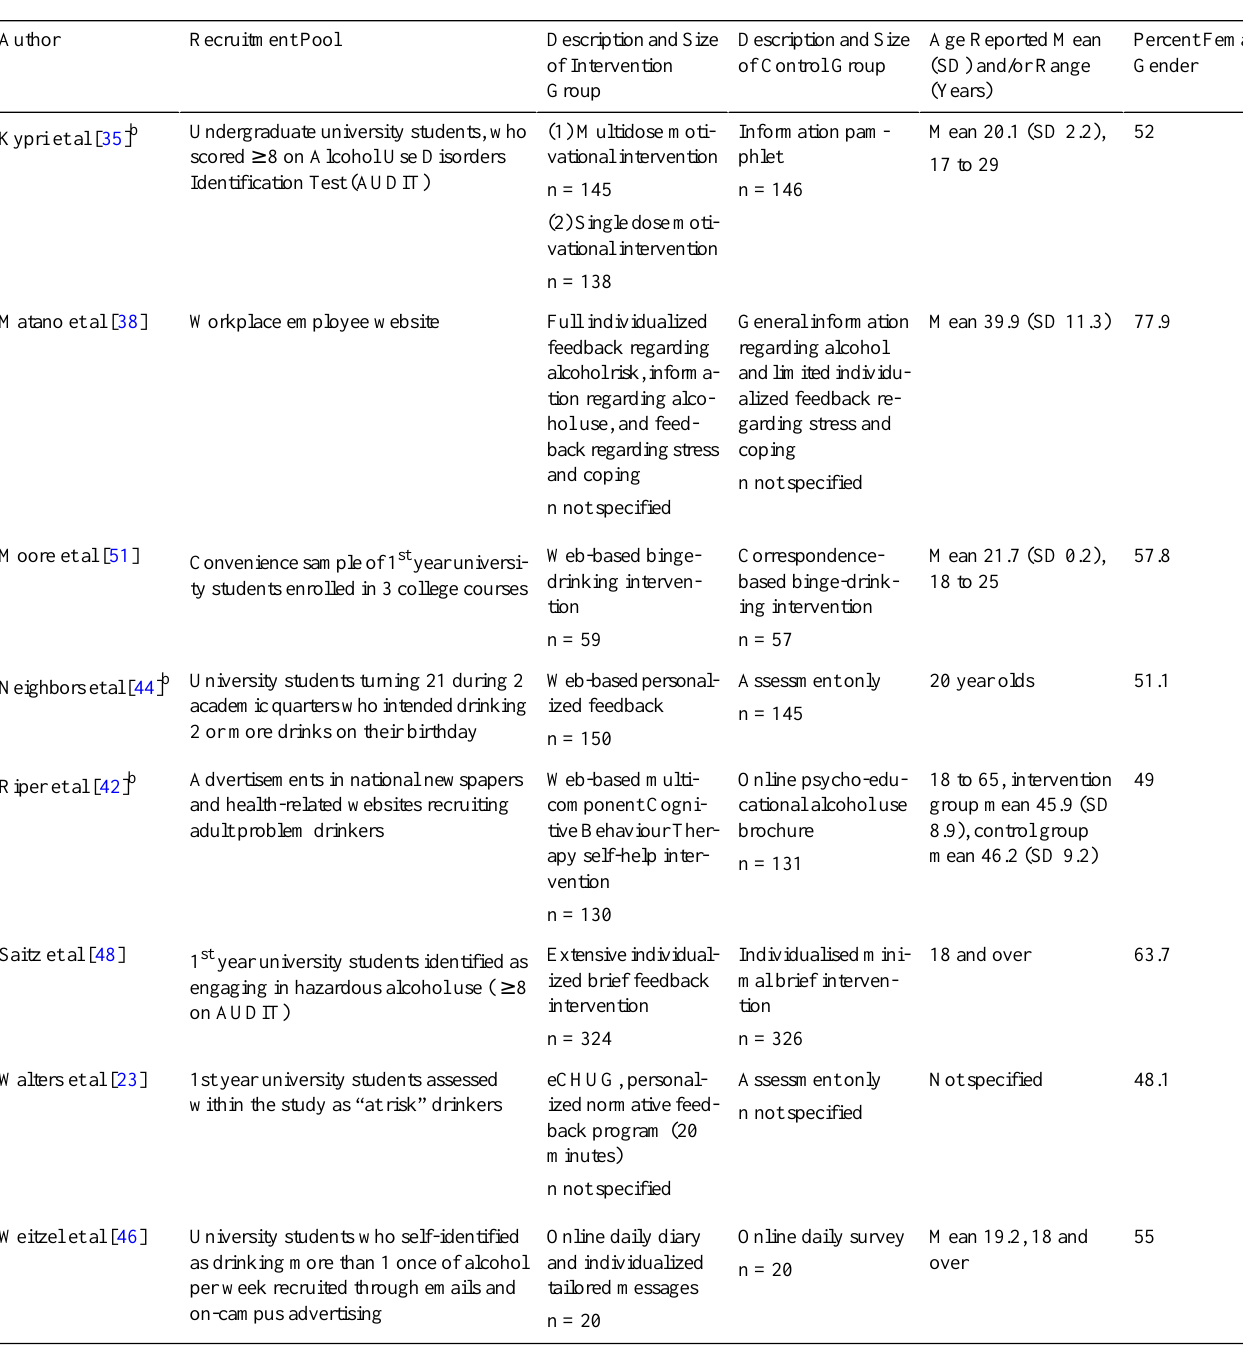
differential effect size was 0.42. If only identified problem drinkers in the Cunningham study [41] are included (rather than the full sample dataset), the effect size rose to 0.47. The pre-post differential effect size for brief personalized feedback programs [41,43,47,49] ranged from 0.02 to 0.81 (mean 0.39, median 0.33), and for the multi-session modularized programs of Riper et al [42] and Hustad et al (AlcoholEdu) [47], a pre-post differential effect size of 0.56 was obtained in each